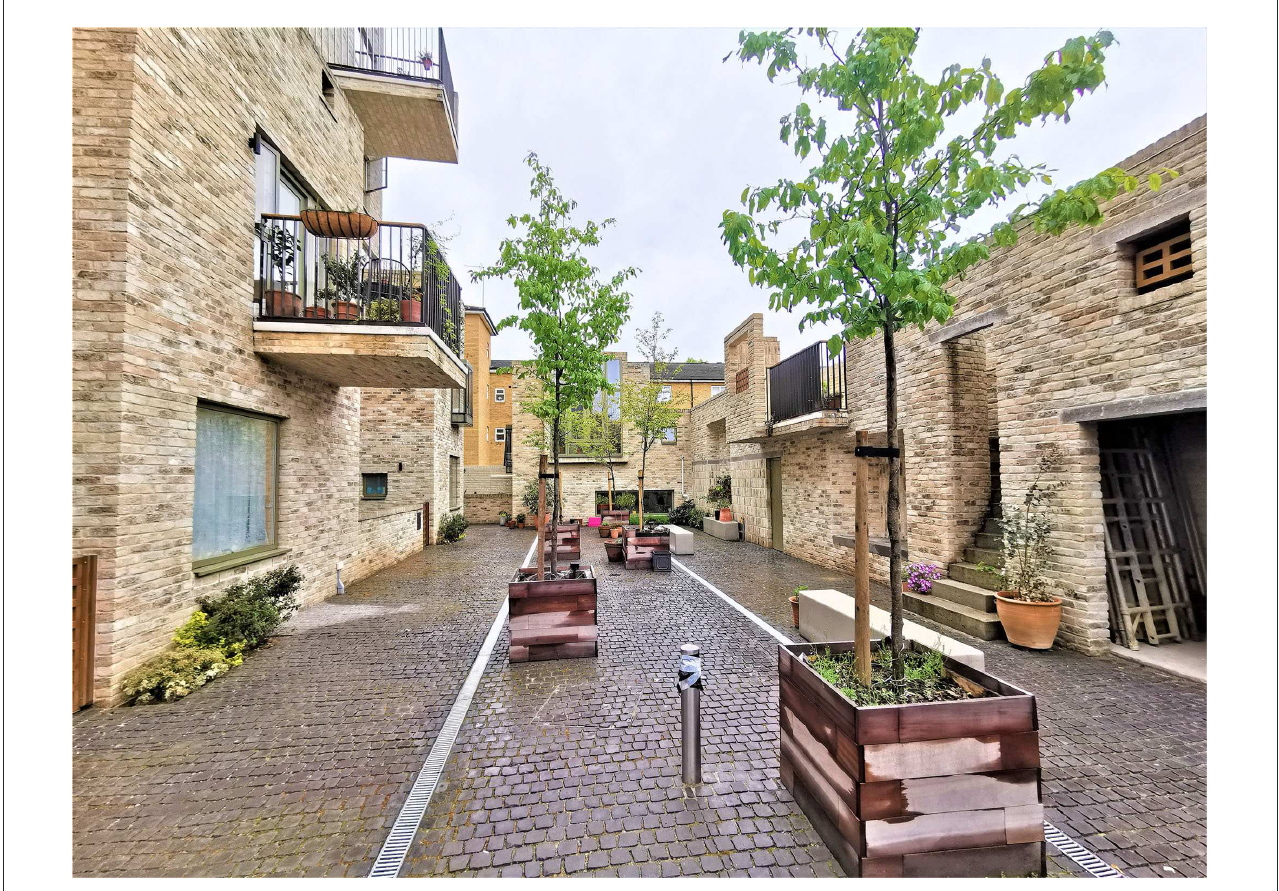
FIGURE5 View of rear courtyard at 95 Peckham